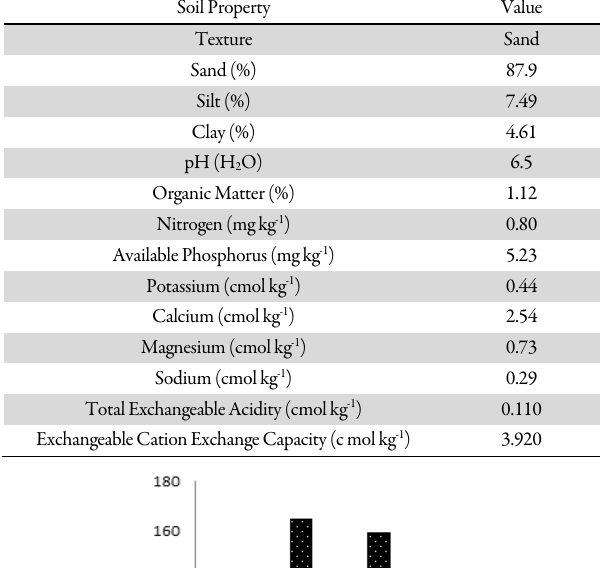
Table 1. Pre-planting soil physical and chemical properties of the experimental site